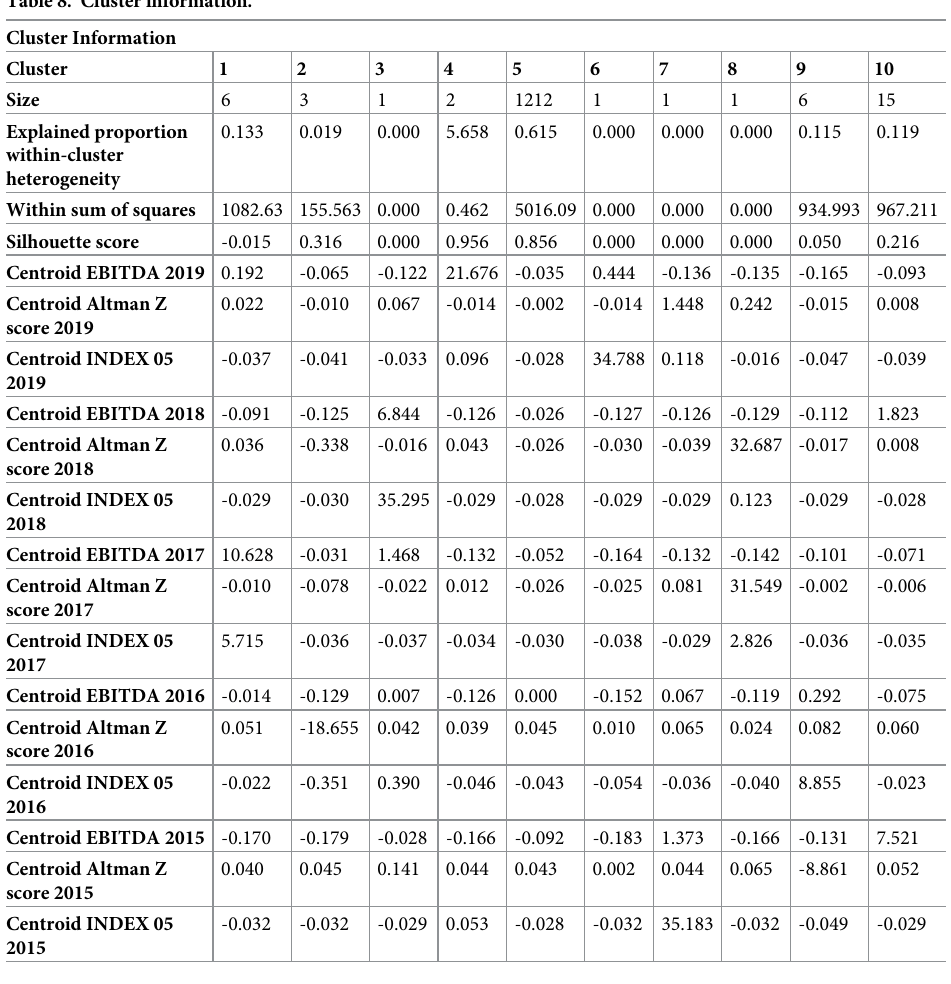
Table 8. Cluster